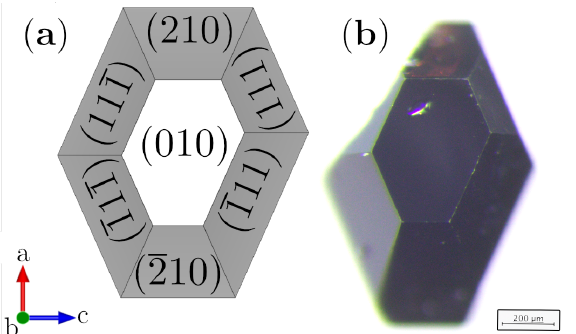
Figure 1. ( a ) Faceting and identification of the crystallographic faces of the Fe 3 BO 6 single crystal. A picture was obtained with the use of VESTA software [28]; and ( b ) microphotograph of a single crystal sample used in the present